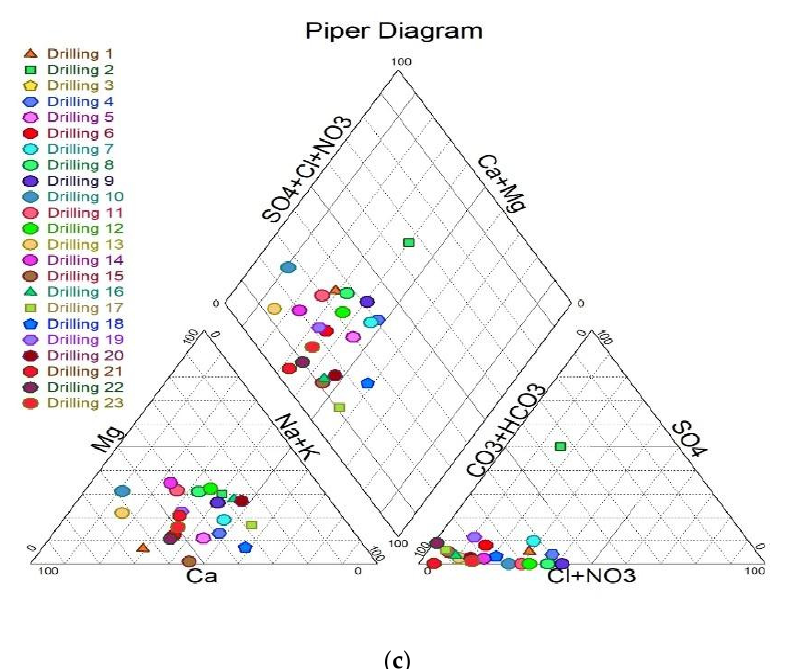
Figure 14. Paper Diagrams. ( a ) Paper diagram 14a of the samples analyzed shows 86.66% calcium and magnesian bicarbonate facies and 3.33% calcium and magnesian chloride and sulfate facies. ( b ) Paper diagram 14b of the samples analyzed shows 90% calcium and magnesium bicarbonate facies and 10% sodium and potassium bicarbonate. ( c ) Paper diagram 14c of the samples analyzed shows 82.60% calcium and magnesian bicarbonate facies, 8.69% sodium and potassium bicarbonate and 4.34% calcium and magnesian chloride sulfate.